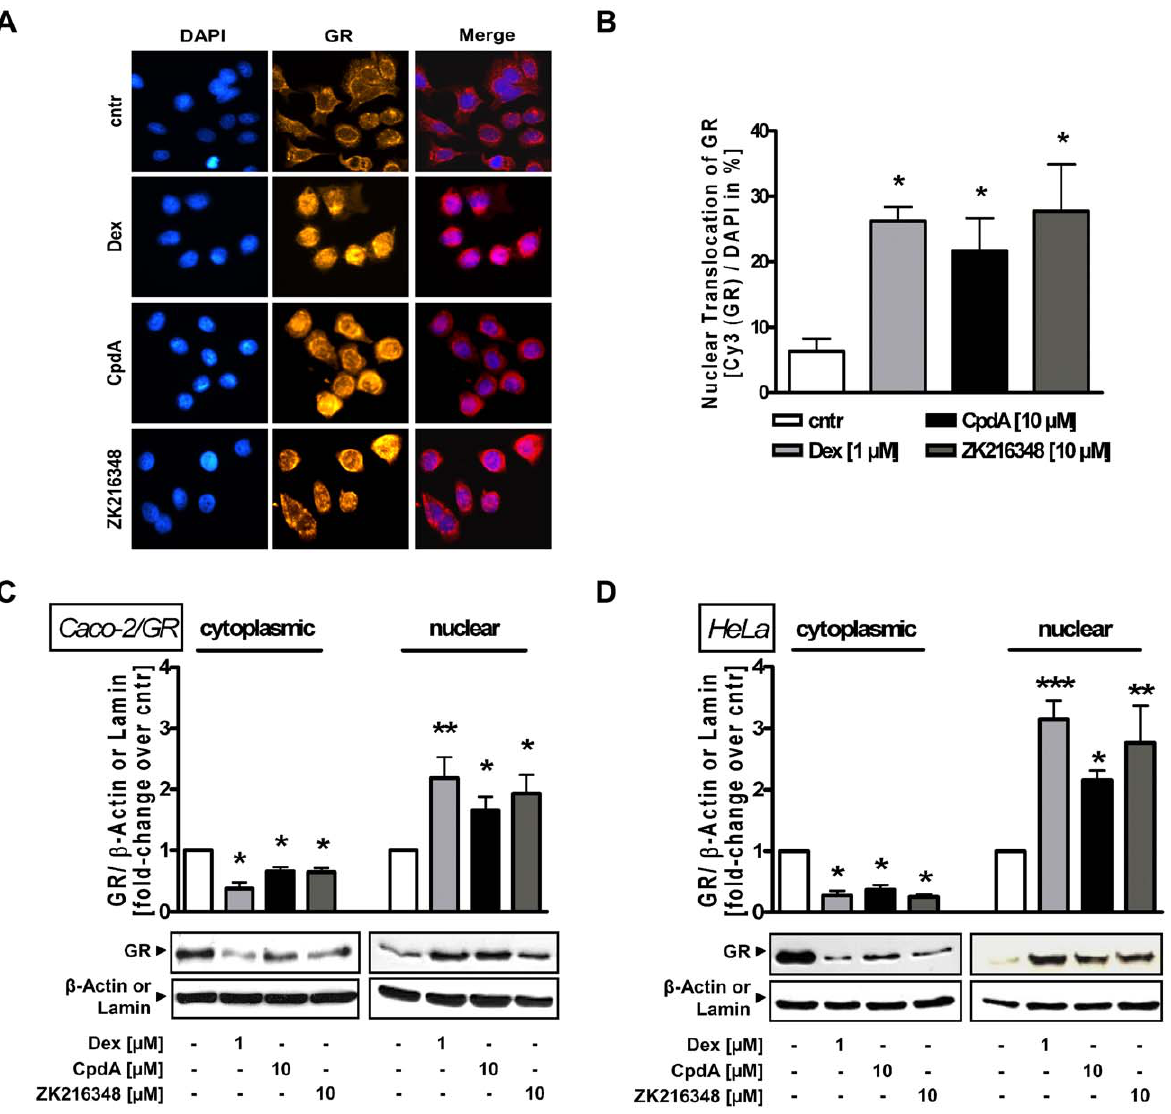
Figure 1. Effect of SEGRAs on GR binding and nuclear translocation. ( A ) Immunofluorescence analysis for GR location in Caco-2 cells. Cells were treated for 3 h with Dex [1 m M], CpdA or ZK216348 [10 m M]. DAPI staining was used for visualisation of the cell nuclei. ( B ) 100 cells were randomly chosen, analysed and the percentage of nuclear GR calculated. Western blot analysis for translocation of GR in ( C ) Caco-2/GR and ( D ) HeLa cell lysates after 3 h cultivation with Dex or SEGRAs. One representative blot of three is shown. Densitometric analysis of GR is normalised to b -actin (cytoplasmic extract) or lamin (nuclear extract), respectively. Bars represent mean 6 S.E.M., n=3, * P , 0.05; ** P , 0.01 relative to vehicle.